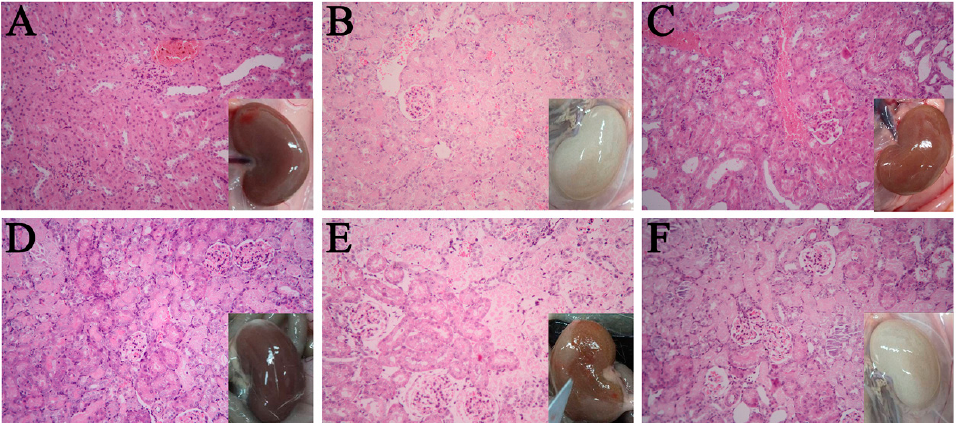
Figure 2. The rats in the total extract of rhubarb and the total anthraquinones groups showed amelioration in renal degeneration from kidney pictures and histopathologic section photos (HE stained, 200× magnification). ( A ) The control group; ( B ) the HgCl 2 alone group; ( C ) the total extract of rhubarb group; ( D ) the total anthraquinones group; ( E ) the total tannins group and ( F ) the remaining components group.